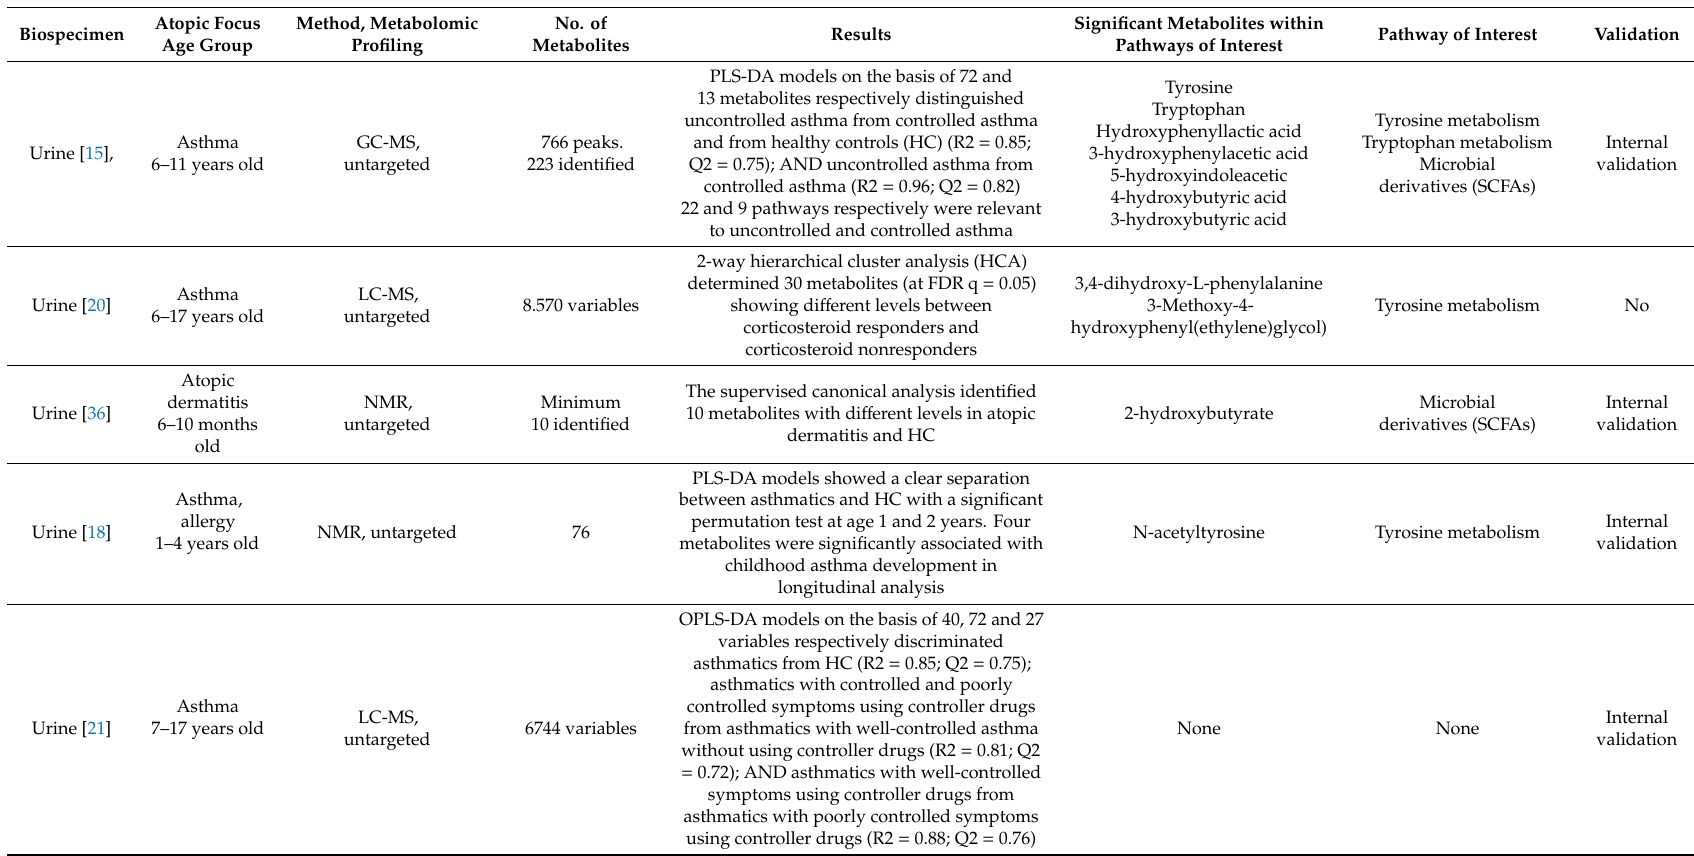
Table 1. Summary of results for the 25 metabolomic studies in